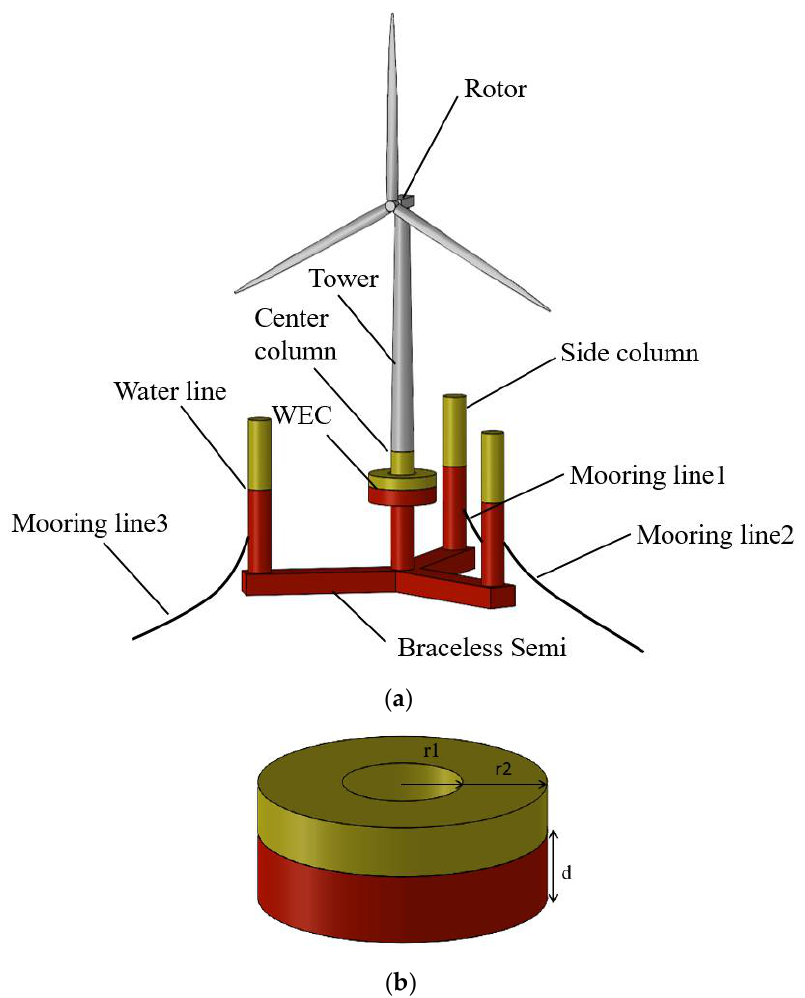
Figure 1. Conceptual diagram of the WEC-wind turbine integrated models. ( a ) Conceptual diagram of the integrated system. ( b ) Detailed view of the WEC model.